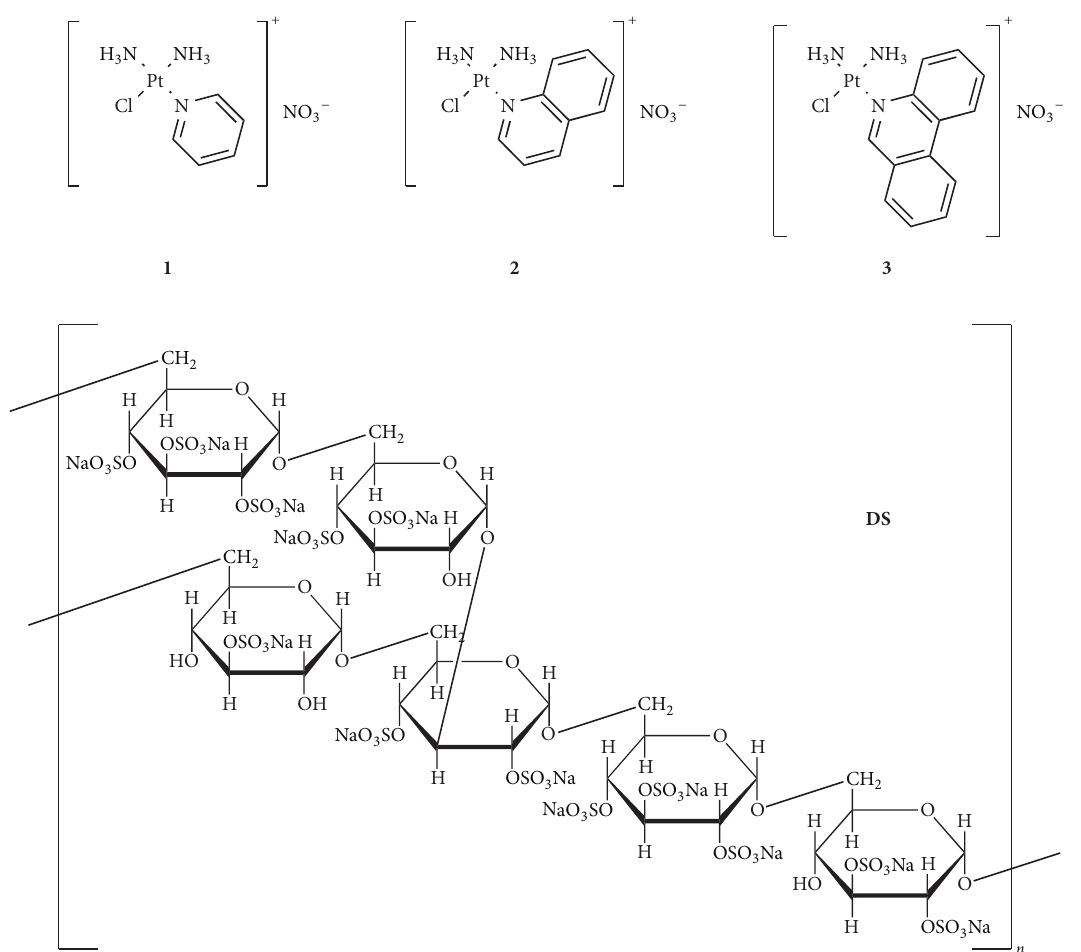
Figure 1: Sketch of the ionic complexes [Pt(Am)Cl(NH 3 ) 2 ] + (Am = pyridine, 1 , quinoline, 2 , and phenanthridine, 3 ) as nitrate derivatives and of dextran sulfate ( DS